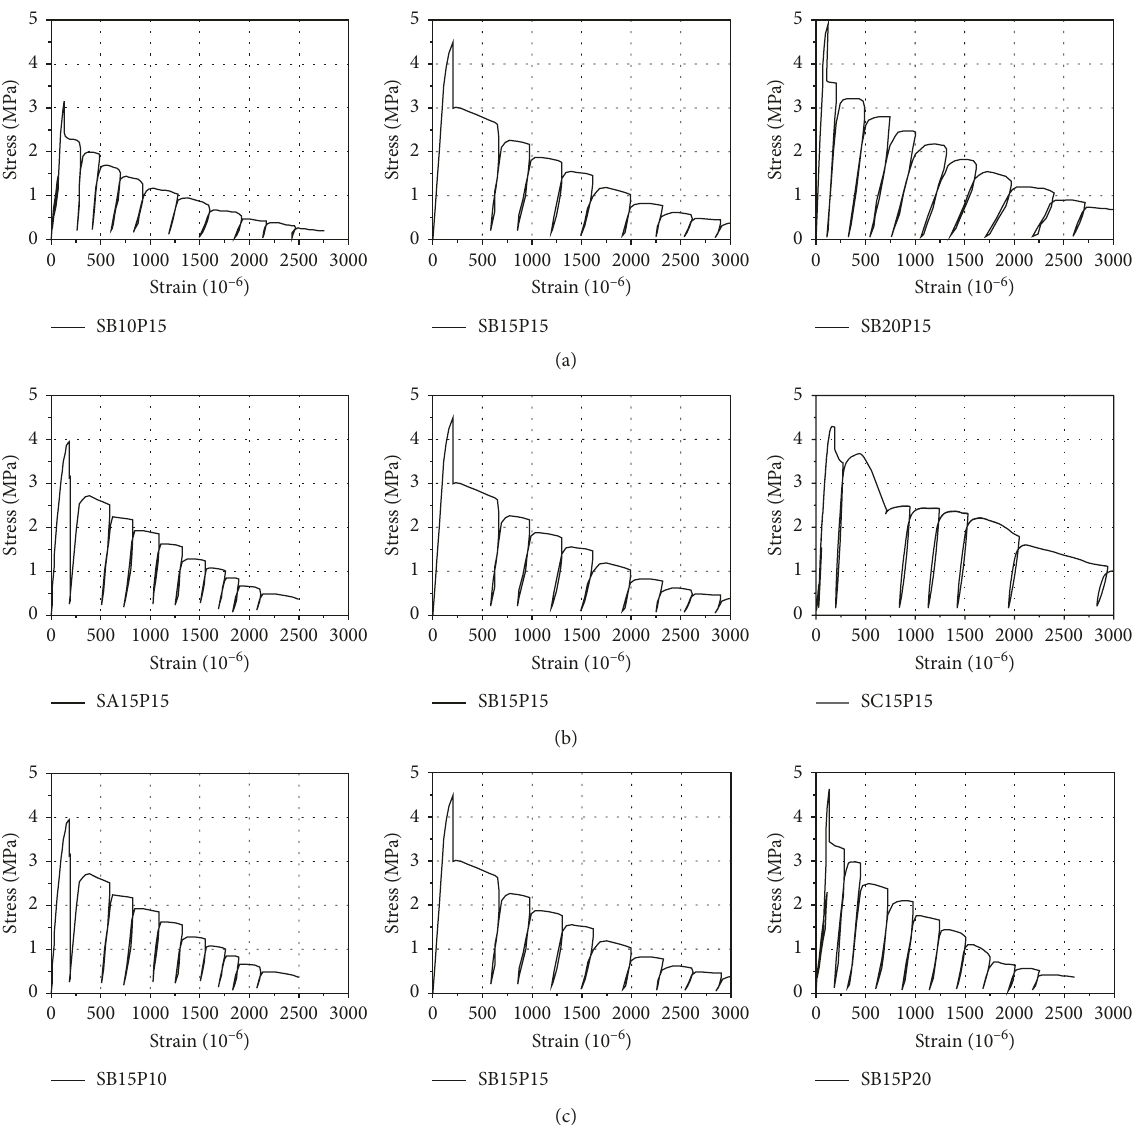
Figure 6: Stress-strain relations of HFRC under cyclic tension: (a) effect of volume fraction of SF; (b) effect of aspect ratio of SF; (c) effect of volume fraction of